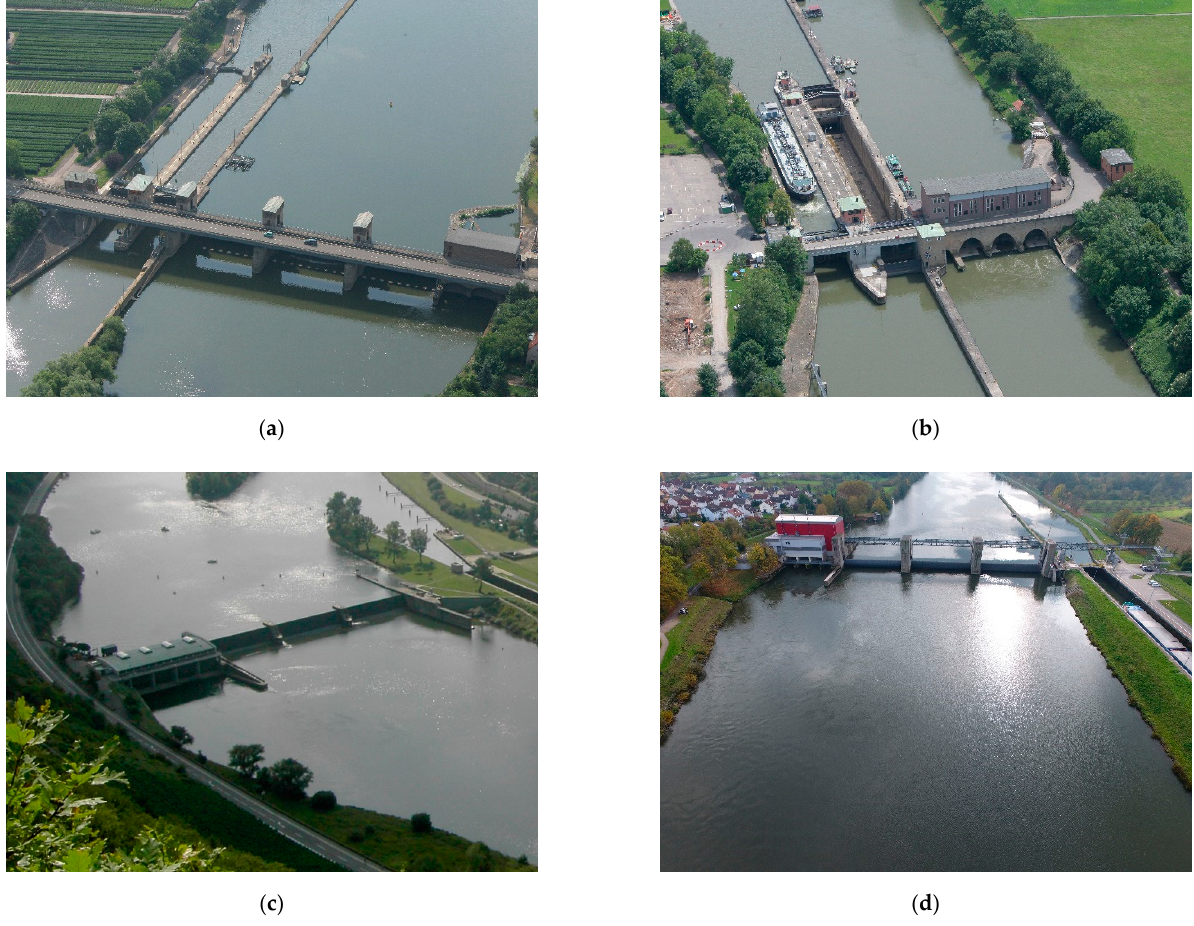
Figure A2. Aerial photos of dams on the Neckar River at ( a ) Lauffen and ( b ) Kochendorf, the Moselle River at ( c ) Lehmen, and the Main River at ( d ) Wallstadt.